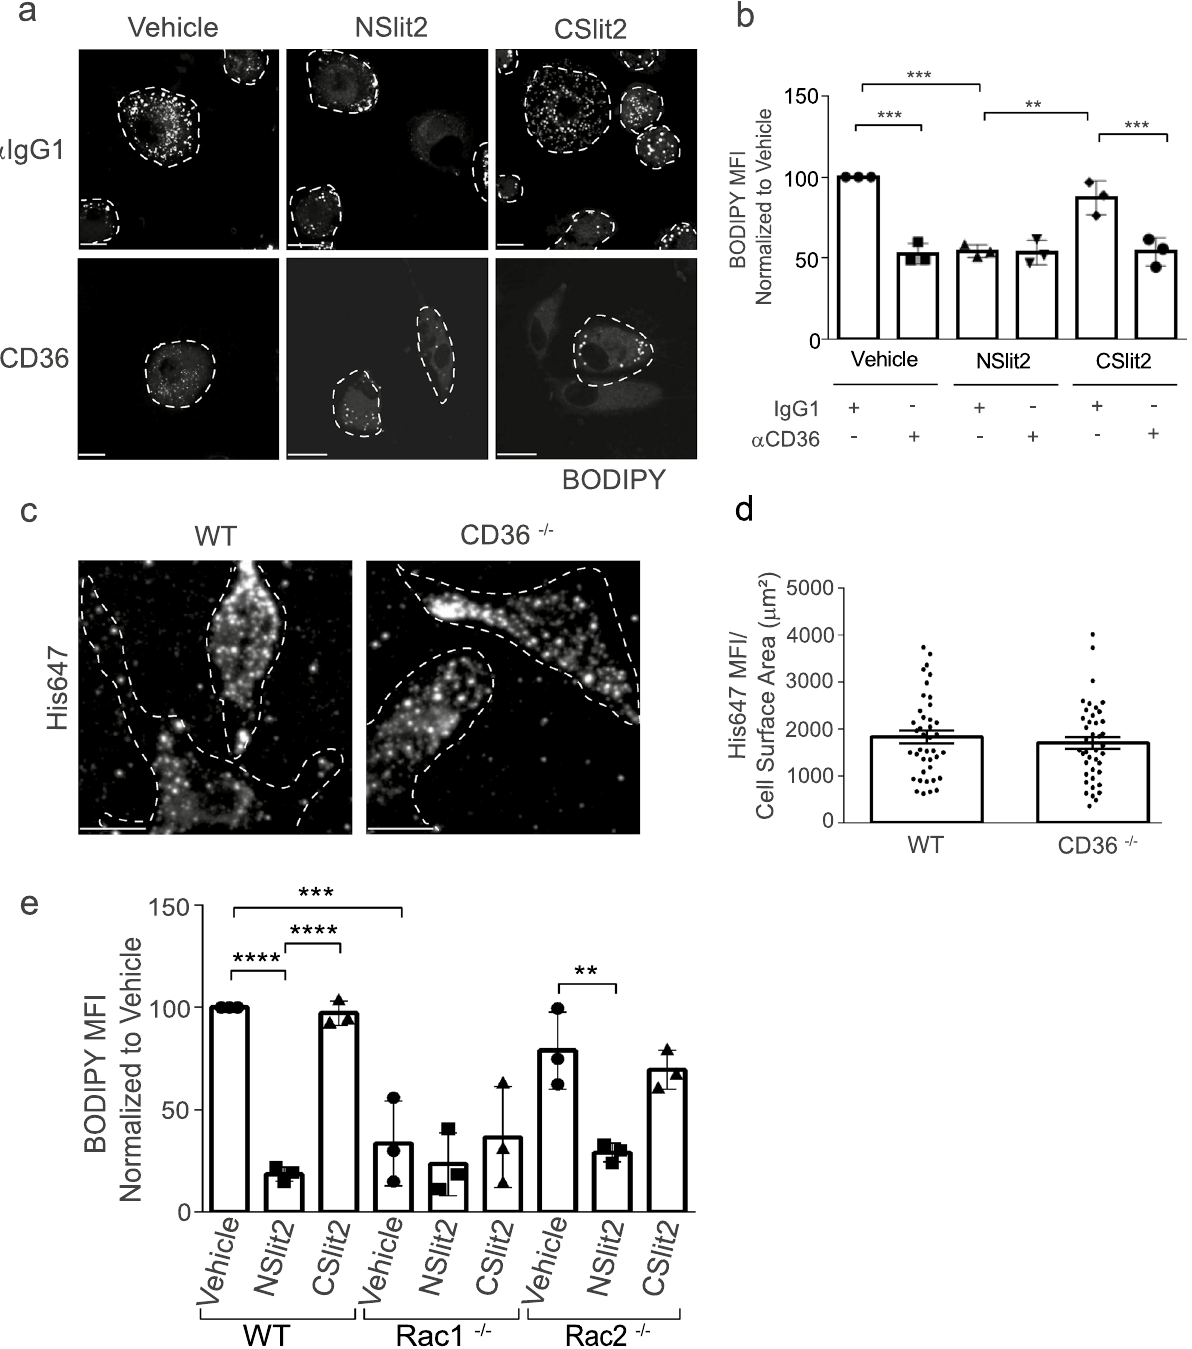
Figure 3. NSlit2-mediated inhibition of oxLDL uptake by macrophages is CD36- and Rac1-dependent. ( a ), M-CSF-induced human macrophages were incubated with anti-CD36 Ab or with an isotype-matched IgG1 Ab for 30 min, followed by incubation with vehicle, NSlit2, or CSlit2. Macrophages were then incubated with oxLDL for 24 h and labeled with BODIPY to visualize intracellular lipid droplets. Representative images were acquired using a spinning disk confocal microscope. BODIPY-labeled oxLDL puncta are shown pseudocoloured white and cell borders are indicated via dashed lines. Scale bar, 10 μm. ( b ), Quantification of experiments performed in ( a ). BODIPY MFI was quantified using ImageJ Software and 20–30 cells per experimental group were analyzed. Data are the mean ± SEM of 3 independent experiments. ( c ), BMDM from wild-type (WT) and CD36 −/− mice were incubated with NSlit2 at 4 °C followed by incubation with AF-647-conjugated anti-His Ab at 4 °C. Cells were fixed and representative images of cell surface labeling were acquired using a spinning disk confocal microscope. Dashed lines indicate cell borders. Scale bar, 10 μm. ( d ), Quantification of ( c ). His647 MFI was quantified using Volocity Software and 20–30 cells were analyzed for each experimental condition. Individual dots correspond to single cells pooled from 4 independent experiments. Vertical bars represent the mean ± SEM of the pooled data. Comparison was determined by an unpaired, t-test, and was not significant. ( e ), BMDM from WT, Rac1 −/− , and Rac2 −/− mice were incubated with vehicle, NSlit2, or CSlit2, then with oxLDL for 24 h. Internalized oxLDL was labeled with BODIPY and measured as described in ( b ). BODIPY MFI was measured in 40–50 cells per experimental group. Data are the mean ± SEM of 3 independent experiments. For ( b ) and ( e ), ** p < 0.01, *** p < 0.001, **** p < 0.0001 were determined by one-way ANOVA using Tukey’s post hoc